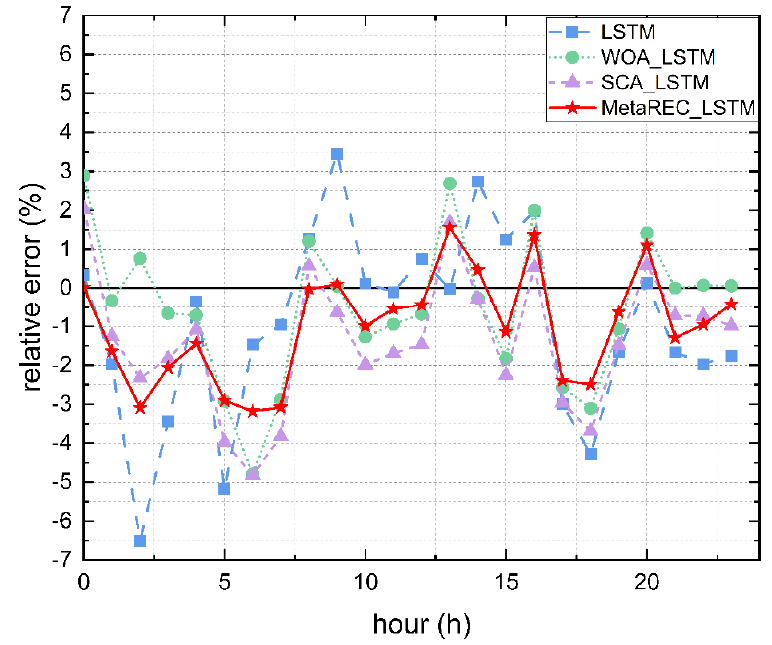
Figure 10. Error rate curves.